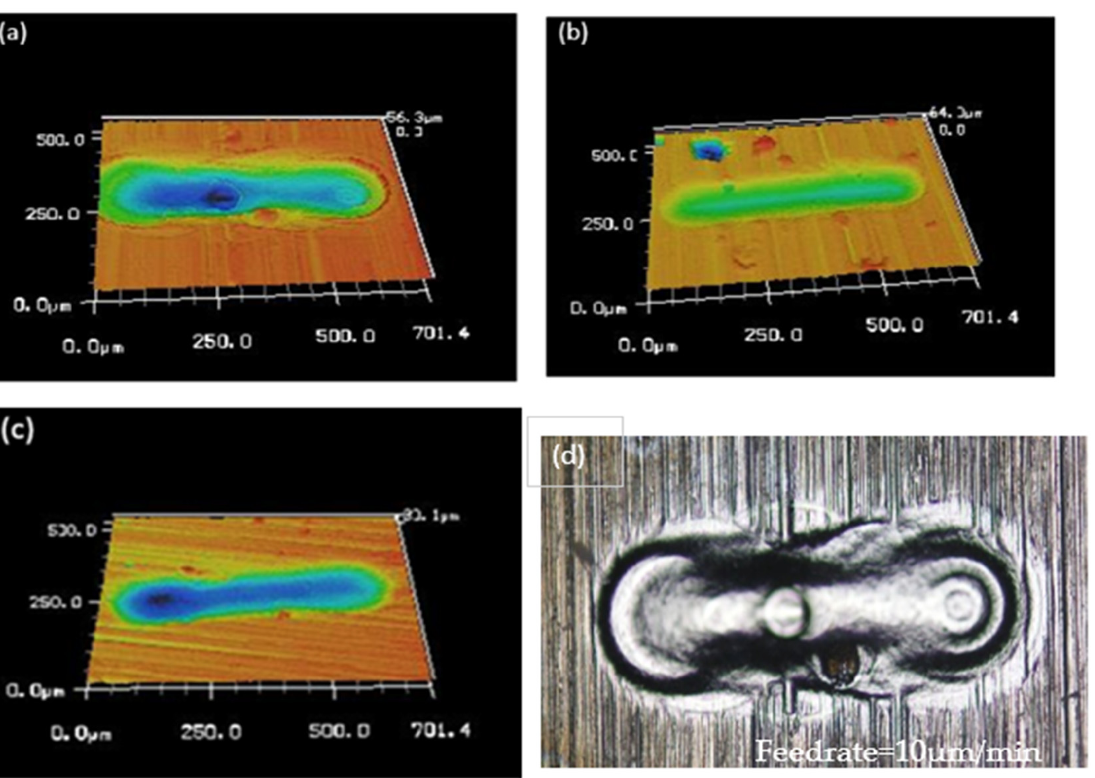
Figure 12. ECM slot milling with feed rate of ( a ) 10 µ m/min, ( b ) 30 µ m/min, ( c ) 60 µ m/min ( d ) OM picture of the slot with feed rate of ( a ).